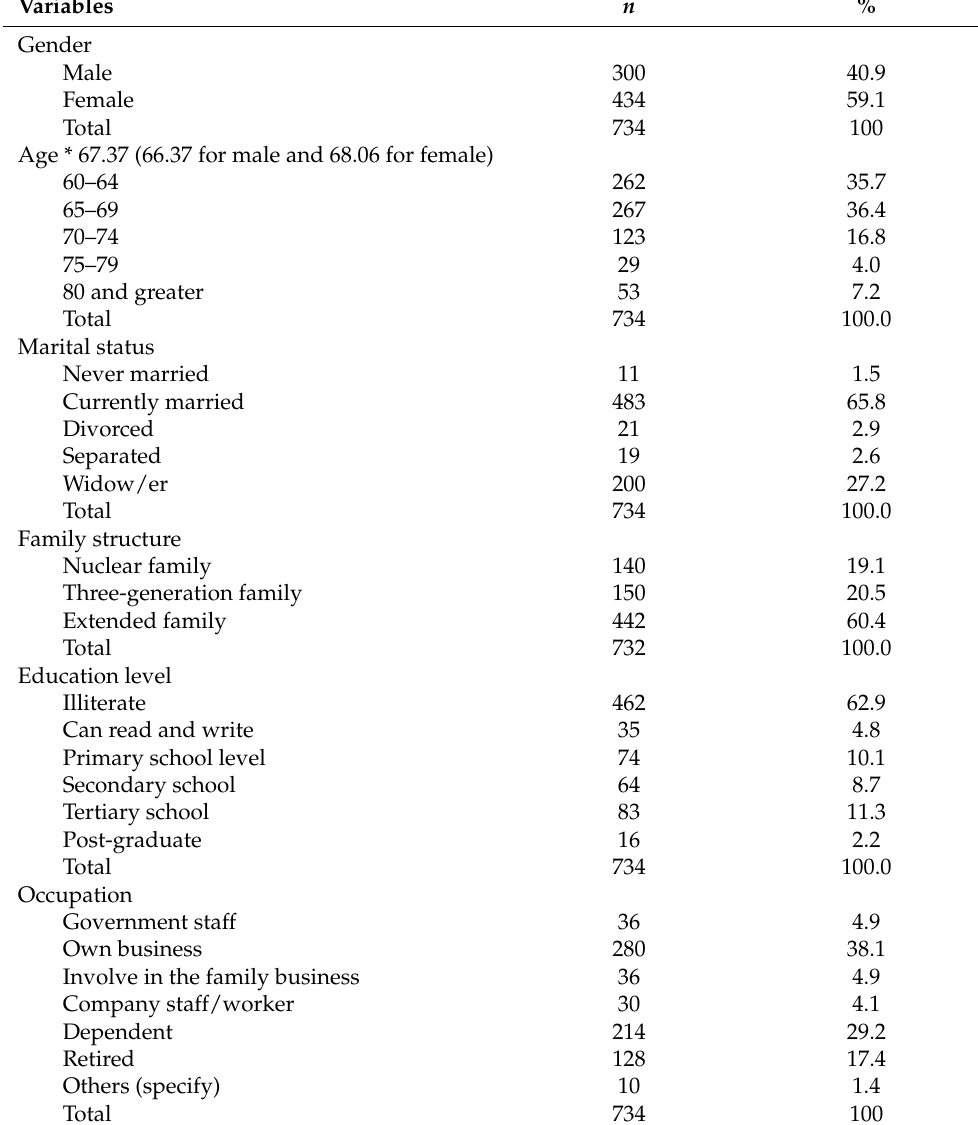
Table 1. Socio-demographic characteristics of the respondent. ( n = 734). * Mean